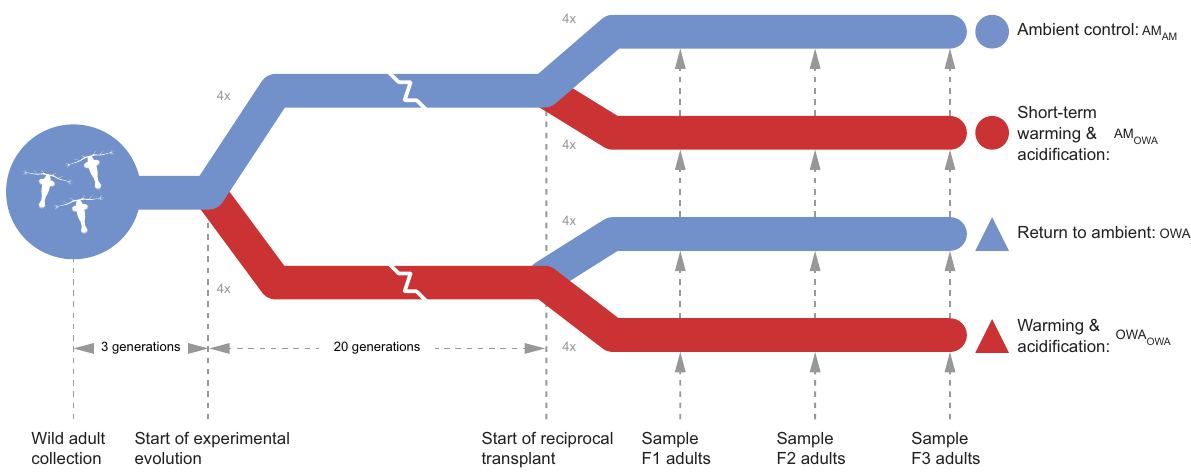
Fig. 1 Schematic of the experimental design. Blue lines are ambient (AM) pH and temperature that represent current conditions ( p CO 2 : 400 ppm; temperature: 18 °C). Red lines are simulated future warming and acidi fi cation (OWA) conditions ( p CO 2 : 2000 ppm; 22 °C). Adult Acartia tonsa were collected from the wild and reared in the lab for three generations. Six hundred laboratory-acclimated adults seeded each of four replicates at AM and OWA conditions where they were reared for 20 non-overlapping generations. At generation 20, each replicate was split in two and transplanted into the same conditions as the previous 20 generations (AM AM , OWA OWA ) and to the opposite condition (AM OWA , OWA AM ). These transplanted lines were reared for three additional generations and sampled for life-history traits at the fi rst generation and genomics at the end of each (Fig. 2, Supplementary Figs. 1 and 2), supporting our previous results that show rapid adaptation to warming and acidi fi cation conditions through selection on hatching success and egg